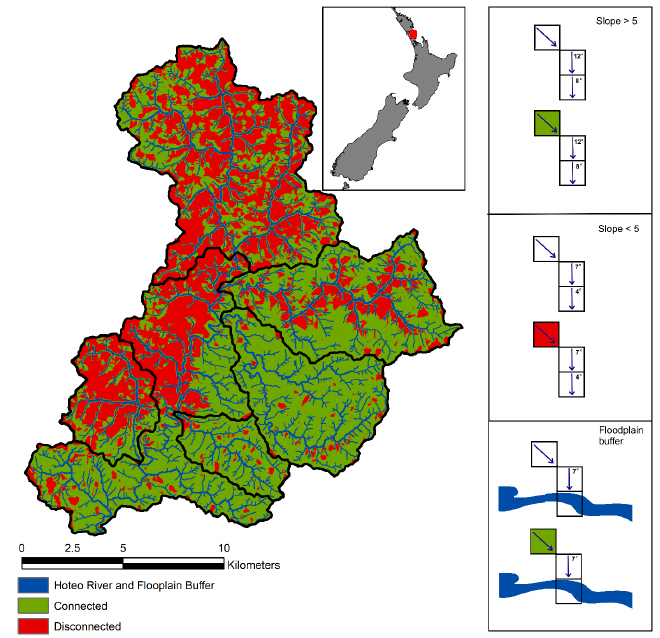
Figure 4. Landscape connectivity for the study area; connected areas (green color) are considered critical source areas of sediment (CSAS) and were used as a mask for land disturbance. A schematic of the rules (as described in Section 2.4) for developing the model are shown on the right side panel. The 1st pixel (upper left corner) is the one being evaluated for connectivity; the next two pixels down the flowpath must both have slope values >5° for the 1st pixel to be considered as connected (green color). If either one of the next two pixels has a slope value <5°, then the pixel being evaluated is considered disconnected (red color). Lastly, if either one of the next two pixels are classified as floodplain, then the pixel is connected (green color).